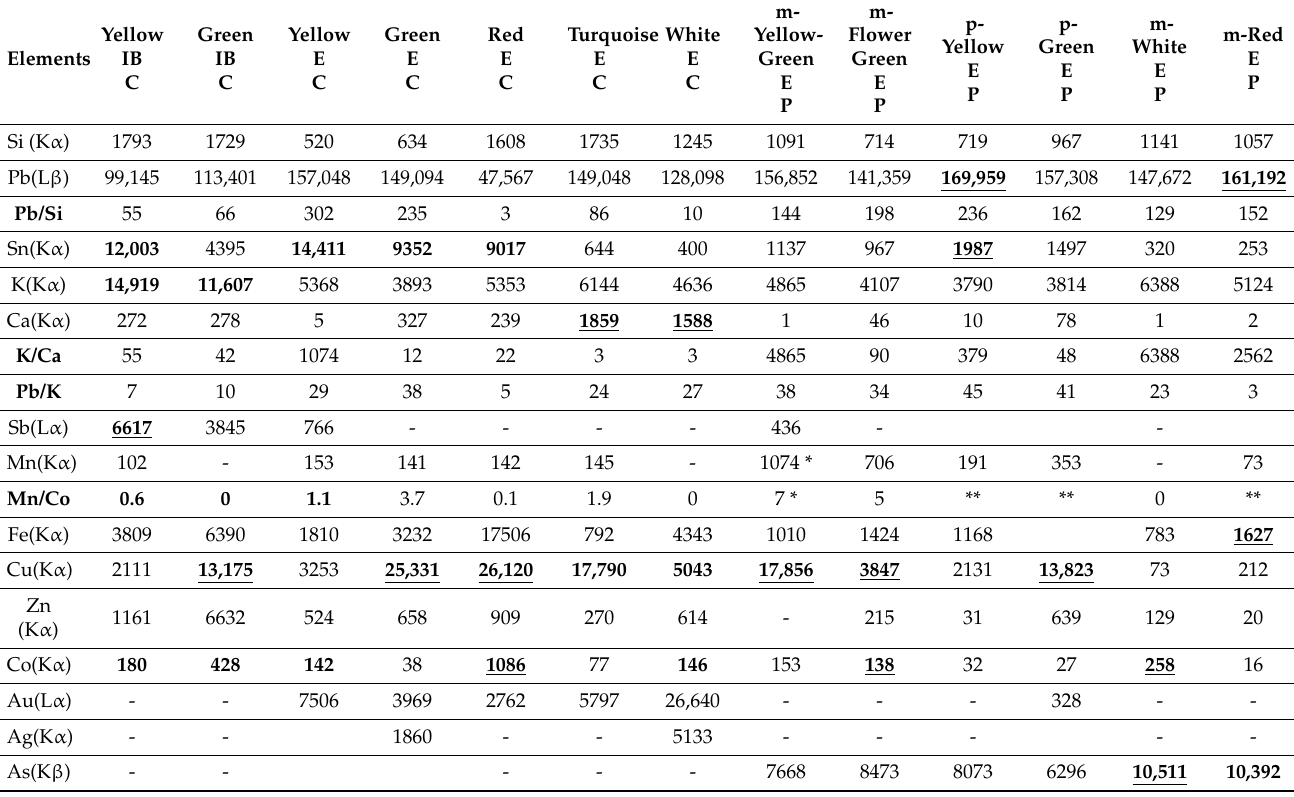
Table 4. Elemental (local) near net count of characteristic peaks for the enameled yellow, green, red and white cloisonn é and painted areas of the Kangxi incense burner (IB) and Qianlong ewer (E). Ratios calculated from the net count area. Elements contributing to coloration are in bold: C: cloisonn é enamel; P: painted enamels, large medallion; m-: small medallion.